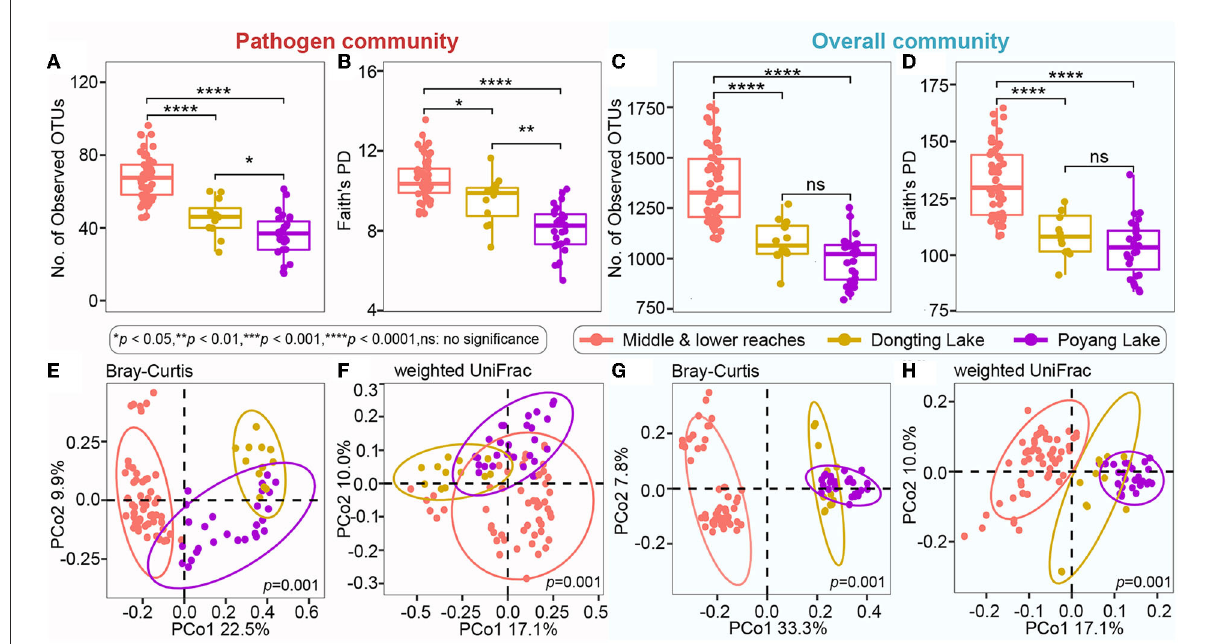
FIGURE4 Microbial alpha diversity and composition of the pathogen and overall communities among different sections. (A–D) Number of observed OTUs and Faith’s PD (phylogenetic diversity) indices in the pathogen community and overall community. The asterisk represents a significant difference between the two groups, * p < 0.05, ** p < 0.01, **** p < 0.0001, ns: no significance. (E–H) Unconstrained PCoA with Bray-Curtis and weighted UniFrac distances that separated by different sections ( p = 0.001, permutational multivariate analysis of variance by Adonis).